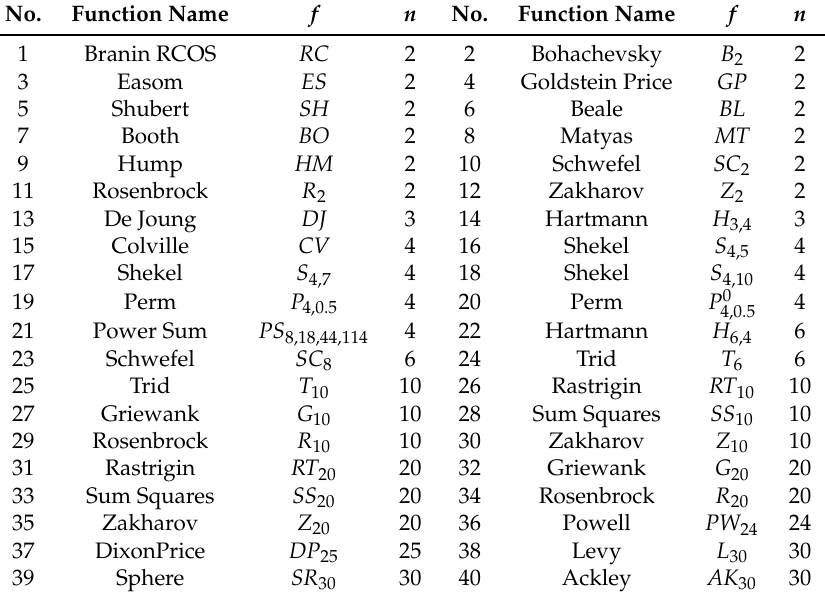
Table 2. Test functions for global optimization: Set B.